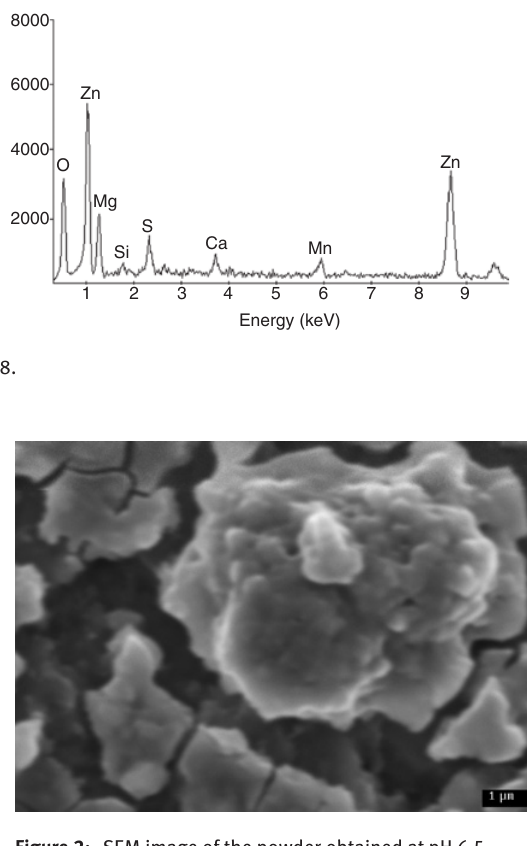
Figure 2: SEM image of the powder obtained at pH